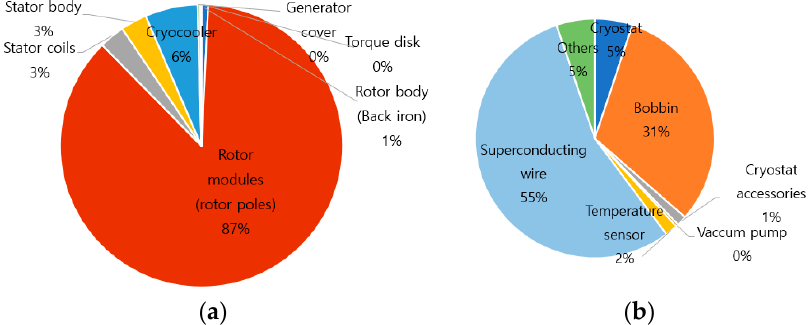
Figure 4. Cost ratio of the SCSG and the rotor module; ( a ) cost ratio of components in the generator and ( b ) cost ratio of components in the rotor modules.